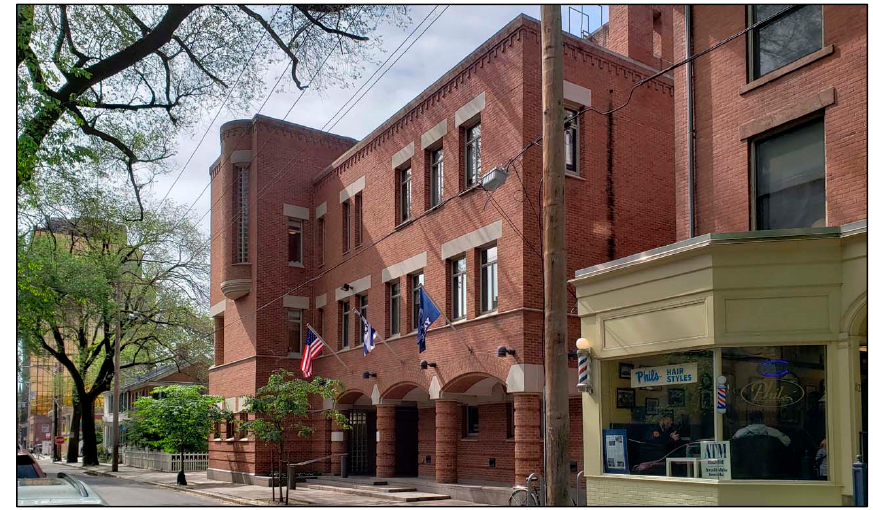
Figure 4. Slifka Center for Jewish Life at Yale, Exterior View Seen from the north along Wall Street. Image Credit: © 2019 Jeremy Kargon.